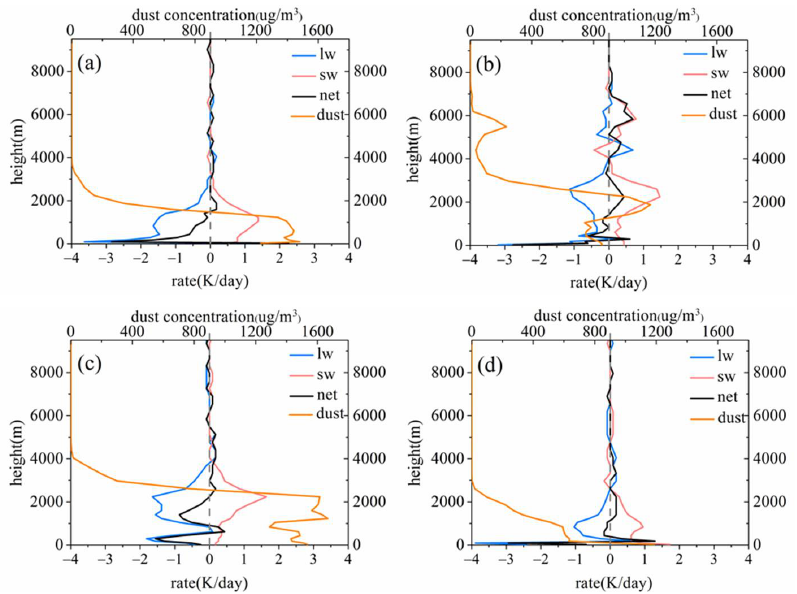
Figure 8. Vertical profiles of dust concentration (orange line) and of the dust-induced changes in the SW (red line), LW (blue line), and net (black line) atmospheric radiative heating at the ( a ) HT, ( b ) KEL, ( c ) KSH, and ( d ) TZH stations in the TB on 30 April 2015, at 01:00 UTC.